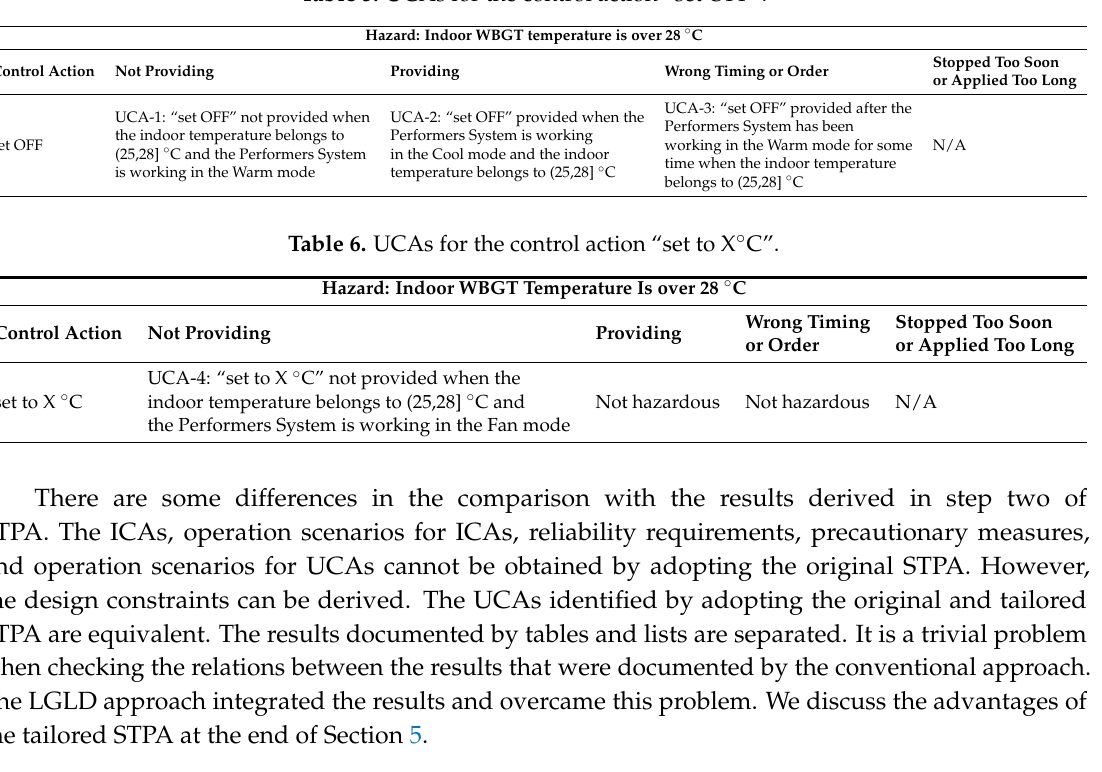
Table 5. UCAs for the control action “set OFF”.